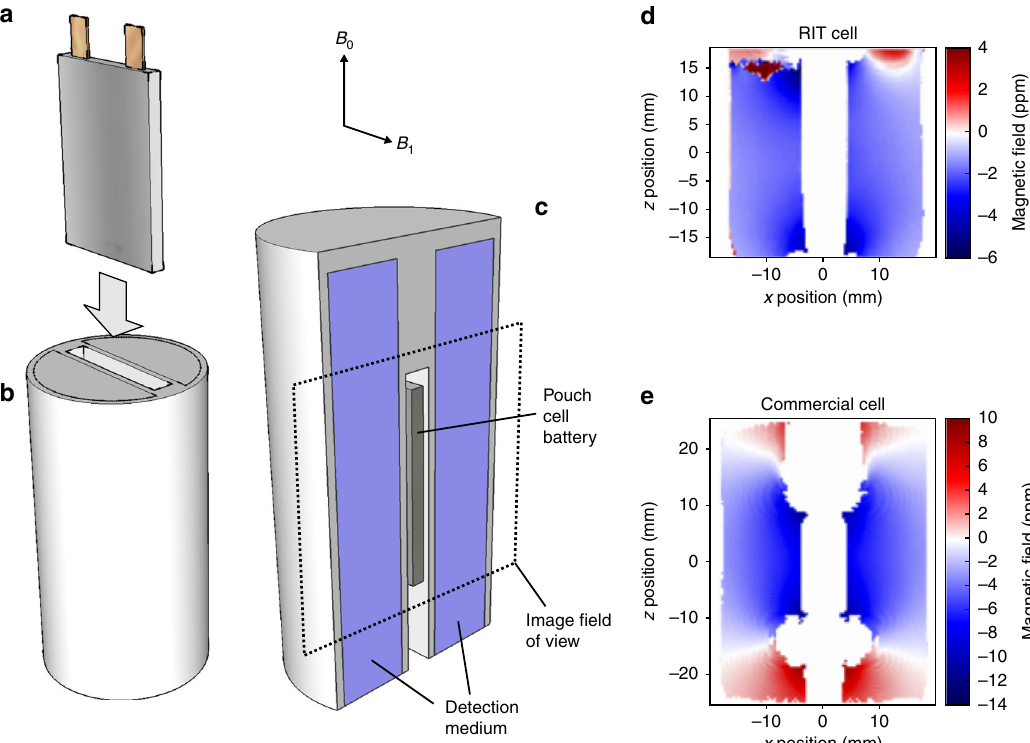
Fig. 1 Magnetic fi eld map measurements for the fully charged cells. a – c Sample placement, and image orientation; d , e fi eld maps measured for the cells. Field maps are referenced here to the empty holder, giving an absolute fi eld map for the Li-ion cell